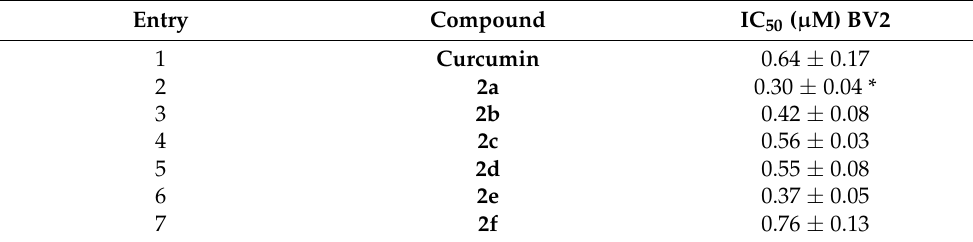
Table 5. Reduction in nitrite production afforded by derivatives 2a – f in BV2 cells stimulated by LPS. BV2 cells were pre-treated with the compound under assay at increasing concentrations (0.1, 0.3, 1 and 10 µ M) for 24 h, then medium was replaced by fresh one containing compounds and LPS (100 ng/mL) for 18 h. The production of nitrite was assessed by the Griess method. Data shown in the Table are the mean of four different experiments, carried out in